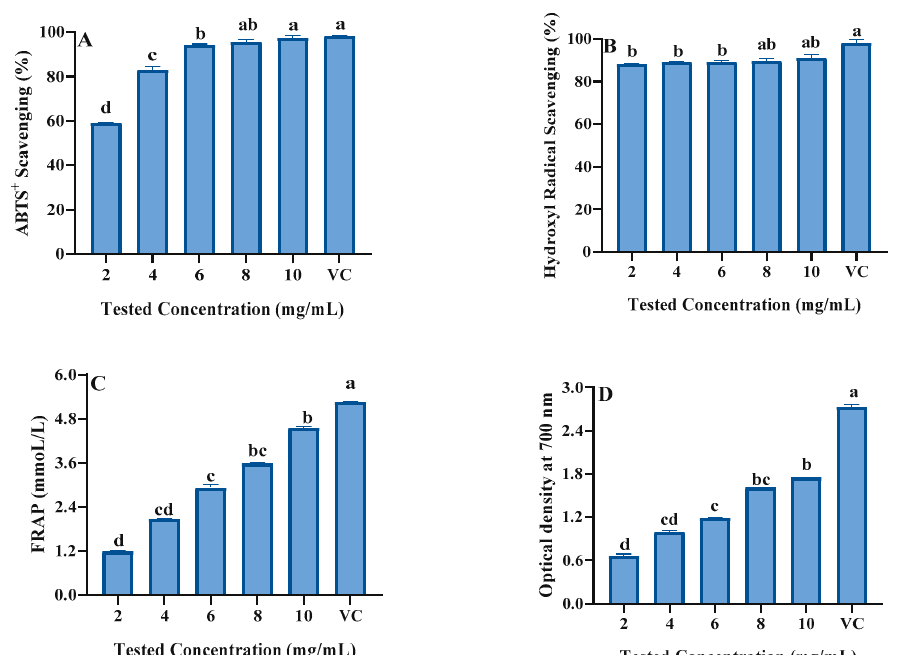
Figure 1. Antioxidant effects of HCEO and positive VC in vitro. Values are expressed as means ± SD ( n = 10). ( A ) ABTS + scavenging activity of HCEO compared with VC (2 mg/mL); ( B ) OH • scavenging activity of HCEO compared with VC (2 mg/mL); ( C ) Ferric-reducing antioxidant power (FRAP) of HCEO compared with VC (2 mg/mL); ( D ) Reducing power of HCEO compared with VC (2 mg/mL). Different letters (a, b, c, d) indicate that the difference is significant ( p < 0.05).